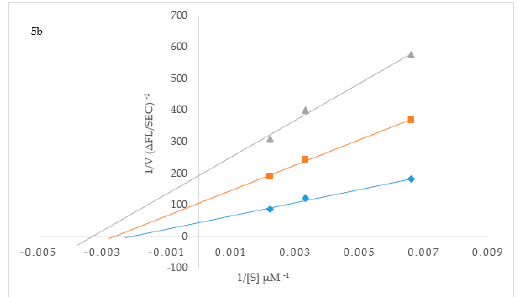
Figure 5. Lineweaver–Burk plots for inhibition of BACE-1 by 2j ( a ) and 3l ( b ), respectively. Blue symbols and fitted straight lines represent enzyme activity in the absence of inhibitor, while orange (4 μ M) and grey (8 μ M) represent various concentrations of inhibitor.